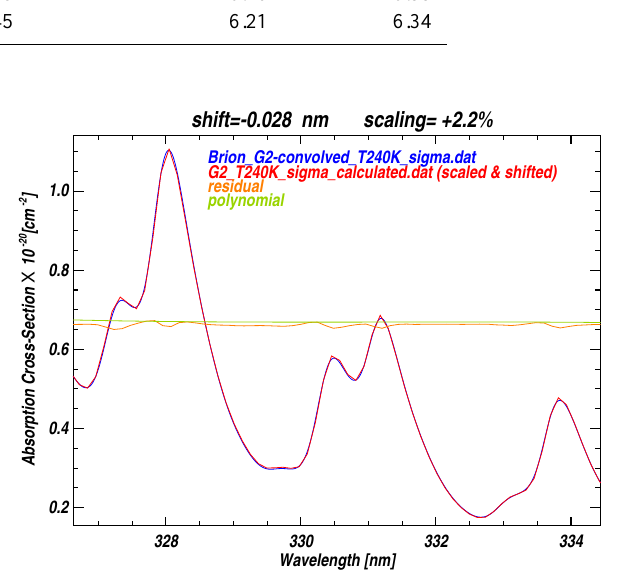
Fig. 5. Comparison of GOME-2 FM3 data with convolved BMD data at 240K in the DOAS fitting window (326.6–334.5nm). BMD data (blue) and the fitted (scaled and shifted) FM3 spectrum are shown together with the residuals (orange) and the retrieved base- line polynomial (green), the latter two vertically shifted for